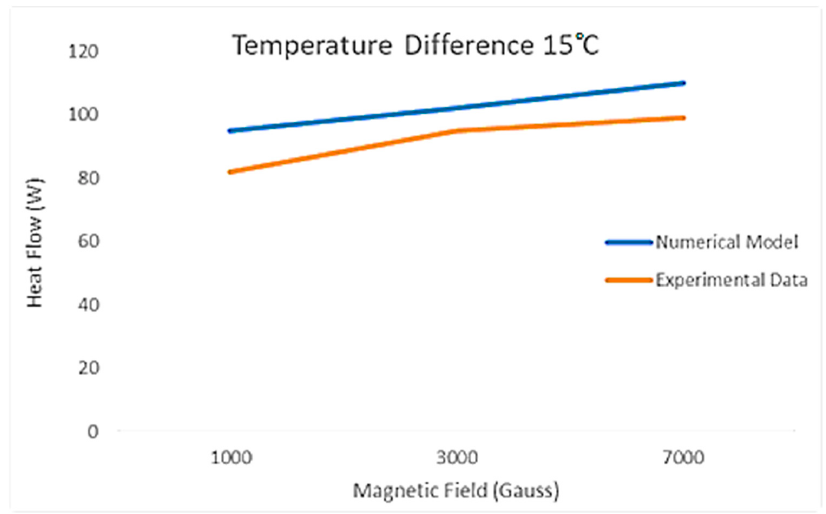
Figure 25. Comparison between present model and data for nanofluid Fe 3 O 4 data with different magnetic fields [50].